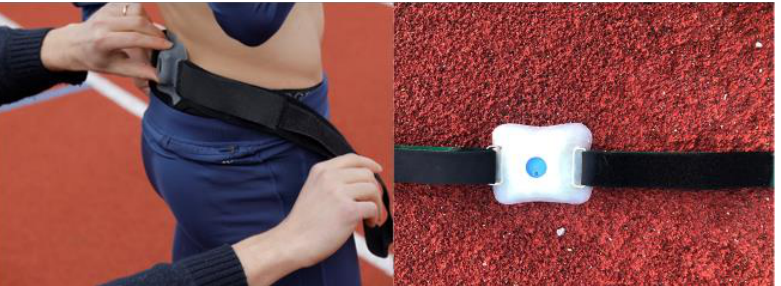
Figure 1. Sensor in the custom-designed neoprene pocket, tightly secured within a waist belt.